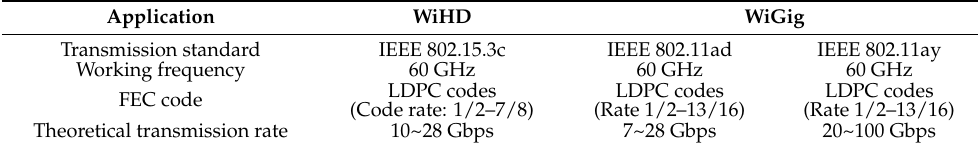
Table 1. Current wireless transmission technology for 60GHz wireless local area networks. Application WiHD WiGig Transmission standard IEEE 802.15.3c IEEE 802.11ad IEEE 802.11ay Working frequency 60 GHz 60 GHz 60 GHz FEC code LDPC codes (Code rate: 1/2–7/8) LDPC codes (Rate 1/2–13/16) LDPC codes (Rate 1/2–13/16) Theoretical transmission rate 10~28